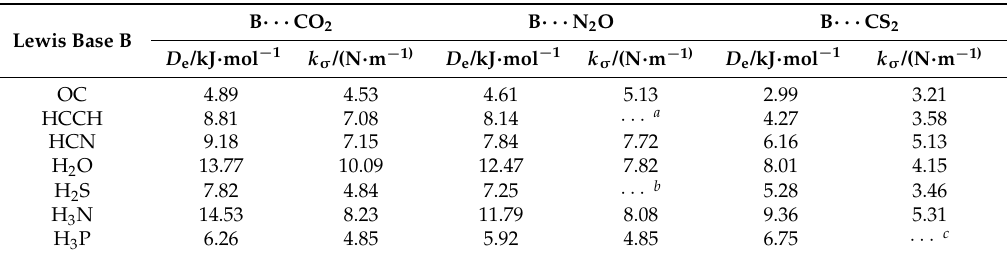
Table 4. Intermolecular dissociation energies D e and quadratic force constants k σ for B · · · CO 2 , B · · · N 2 O, and B · · · CS 2